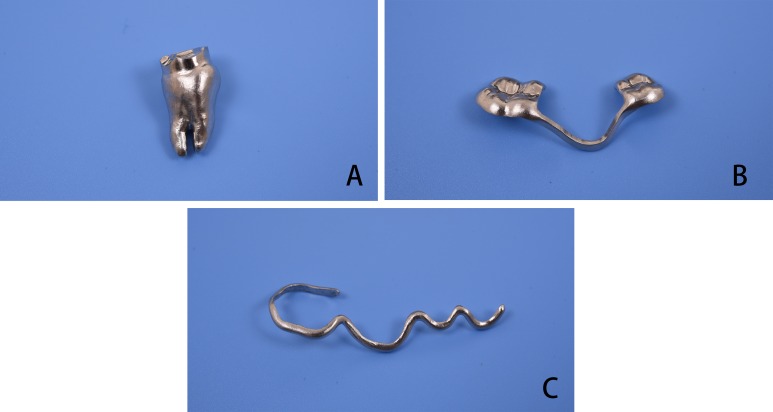
Three-dimensional print ing of surgical guides.(A) Replica of the donor tooth and the local split, (B) individual surgical template, (C) individual arch bar.